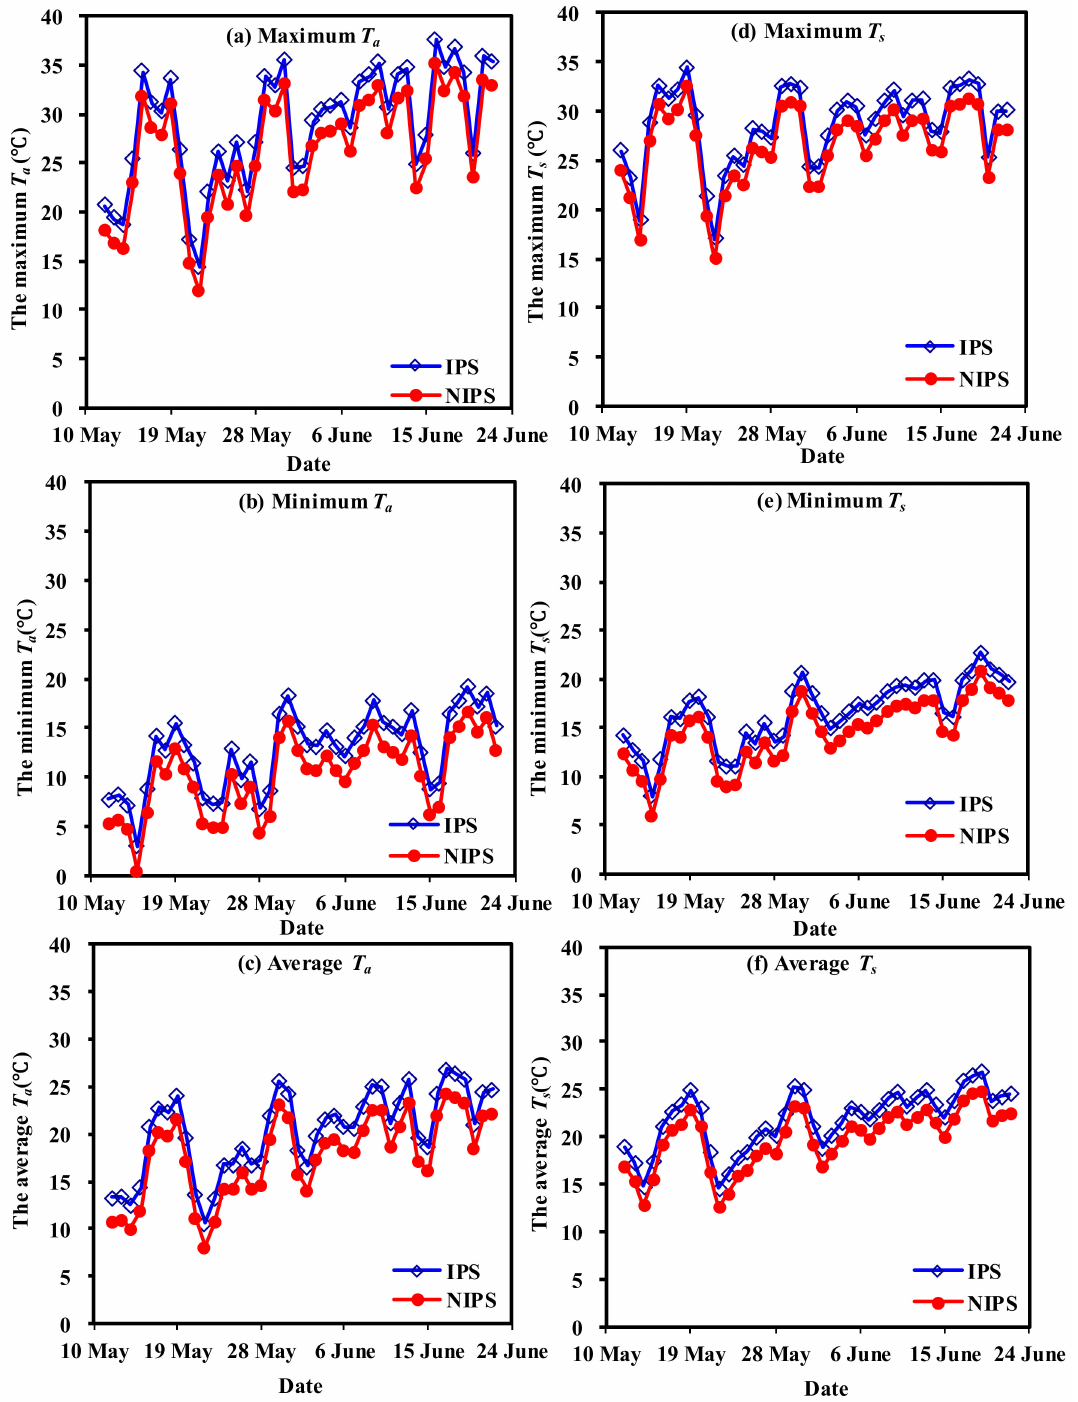
Figure 3. Effects of IPS on air temperature T a ( a ) maximum T a , ( b ) minimum T a , ( c ) average T a and soil temperature T s ( d ) maximum T s , ( e ) minimum T s , ( f ) average T s during C1 of Chinese Flowering Cabbage